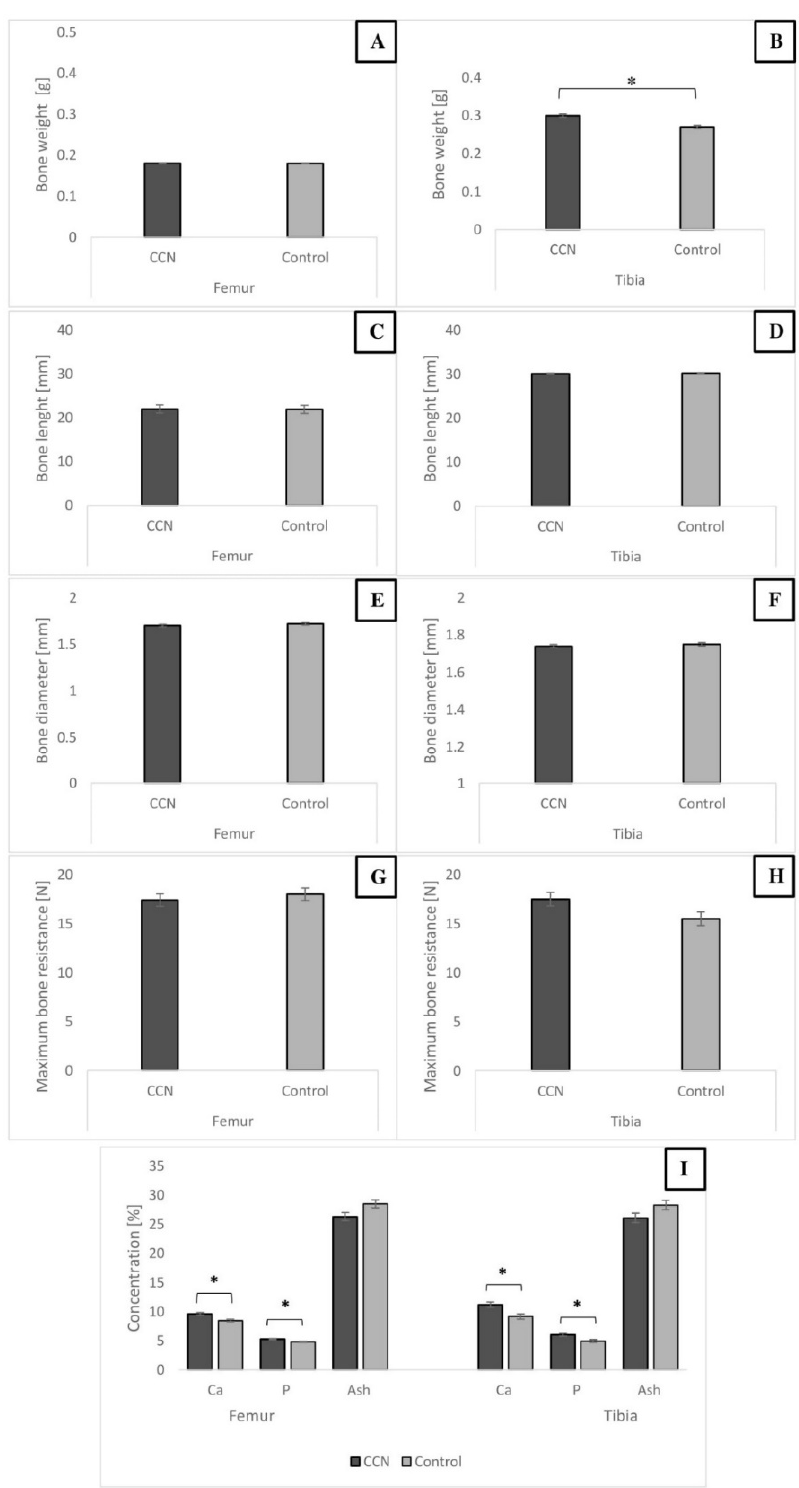
Figure 4. Selected parameters of chicken embryo bones on 20 day after IOI with CNN. Femur and tibia weight ( A , B ), femur and tibia length ( C , D ), femur and tibia middle diaphysis diameter ( E , F ), femur and tibia maximum resistance to breaking ( G , H ), femur and tibia Ca, P and ash content ( I ). * Value on bars differs significantly at p ≤ 0.05. The error lines represent standard error of mean.